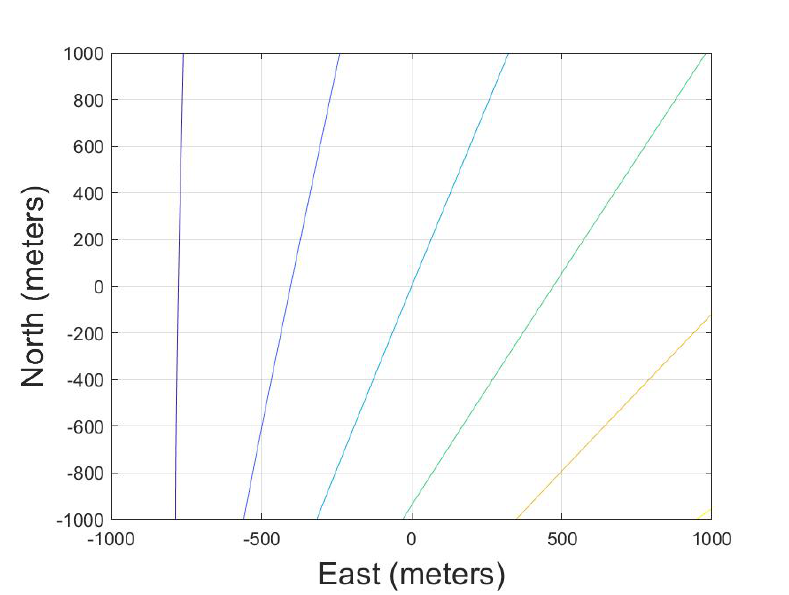
Figure 14. The range direction in the experiment configuration.